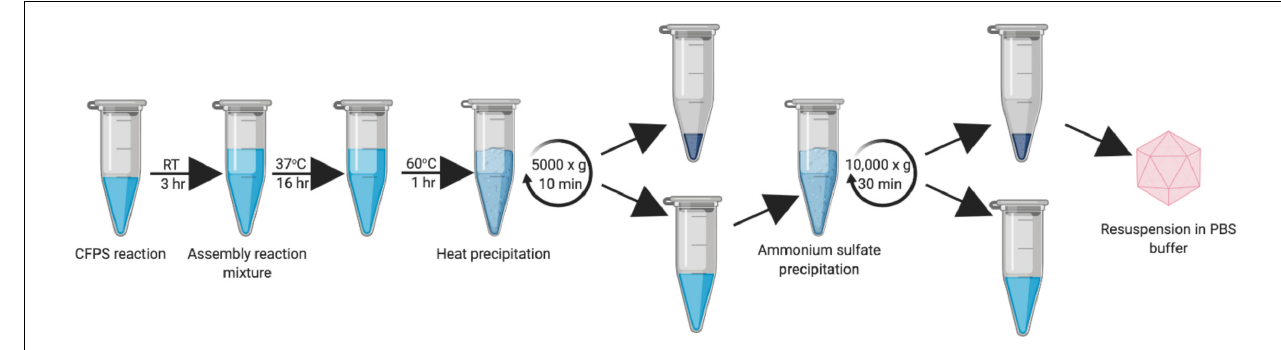
FIGURE 5 | Updated work-flow schematic of HBc VLP synthesis, assembly, heat treatment and ammonium precipitation. Created with biorender.com.